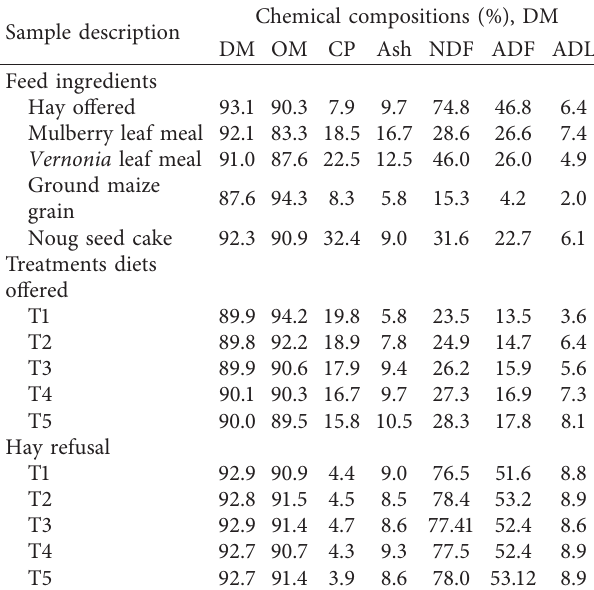
Table 2: Chemical compositions of experimental feed ingredients, treatments diet, and offered and refused hay.